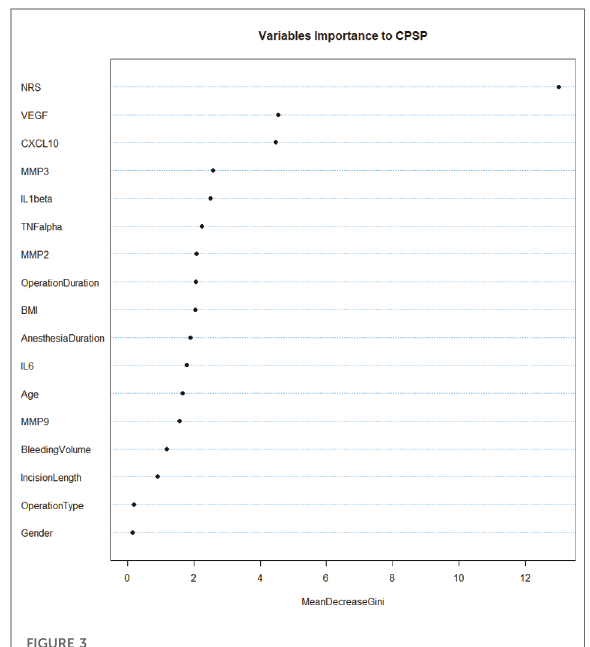
FIGURE 3 Random forest analysis of clinical variables and